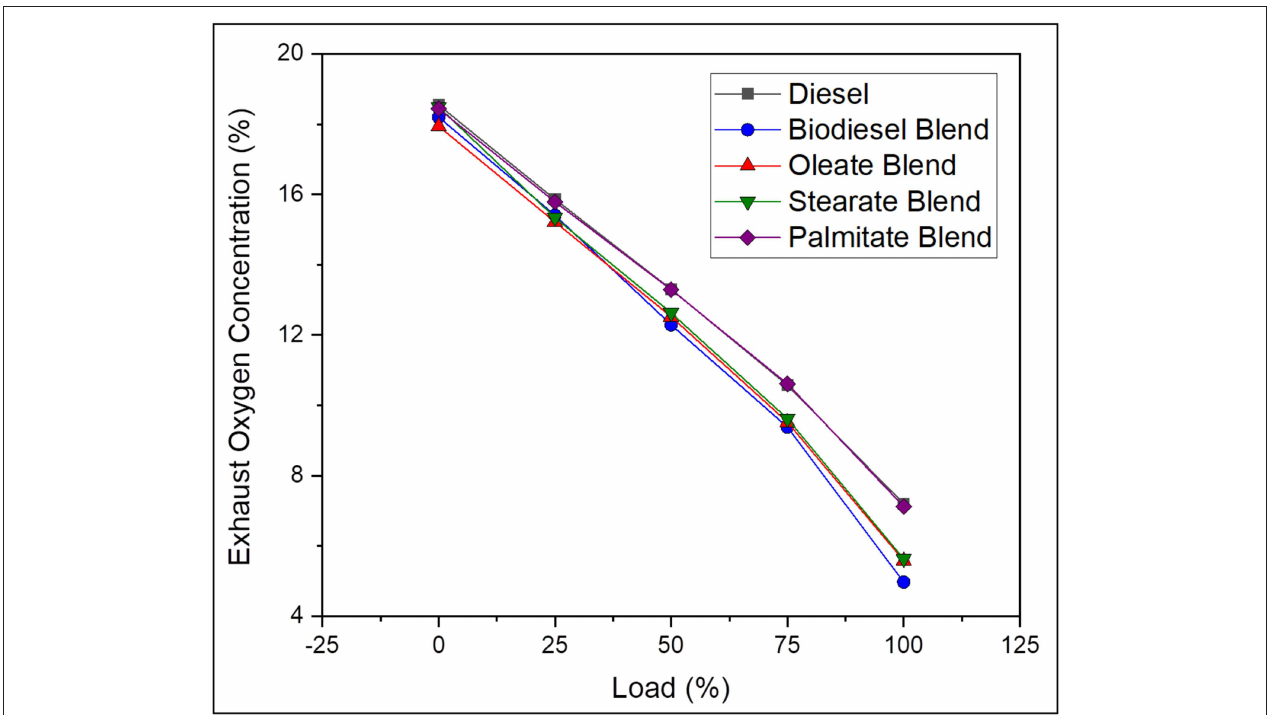
FIGURE 8 | Exhaust Oxygen concentration of diesel and blend samples for varying load conditions.